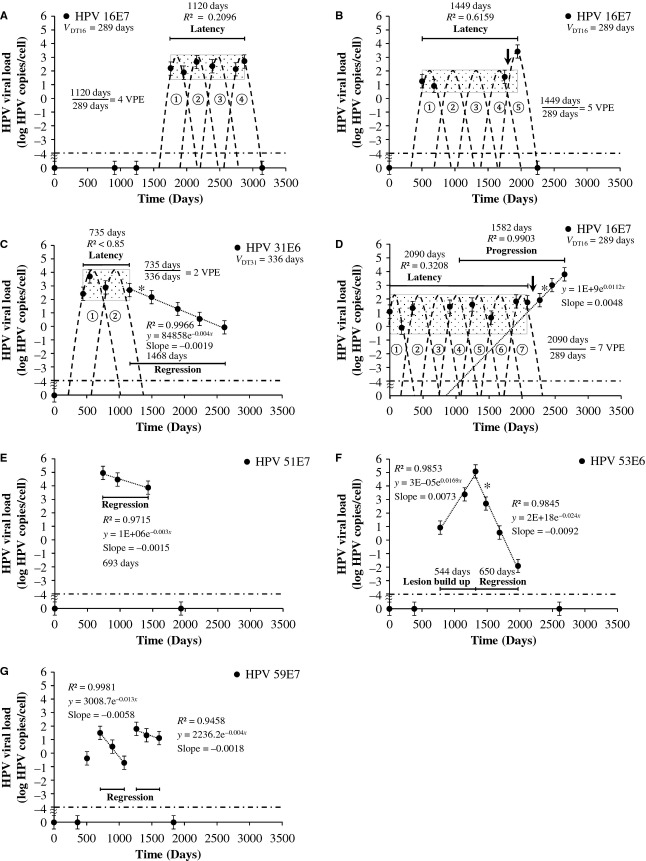
Representative cases showing the different viral load patterns in latency and regression. (A) Serial virion producing episodes with latency (B) Serial virion producing episodes with latency (exit scenario 1) (C) latency followed by regression (exit scenario 2) (D) Latency followed by progression (E) regression (F) progression or lesion build up followed by regression (G) Serial regression of clonal populations. Dash-dotted line, threshold of positivity (0.0001 HPV copies/cell); VDT, median viral doubling time in single type infections leading to CIN3+ 7; Number of virion producing episodes (VPE) in latency (R² < 0.85) = period of type specific HPV DNA detection (days)/HPV type specific VDT (days); dashed line, virion producing episode; arrow: biopsy CIN 0; dotted rectangle, latency threshold; dotted line, progression or regression (R² > 0.85); *hinge 7. Slope in HPV copies/cell per day.